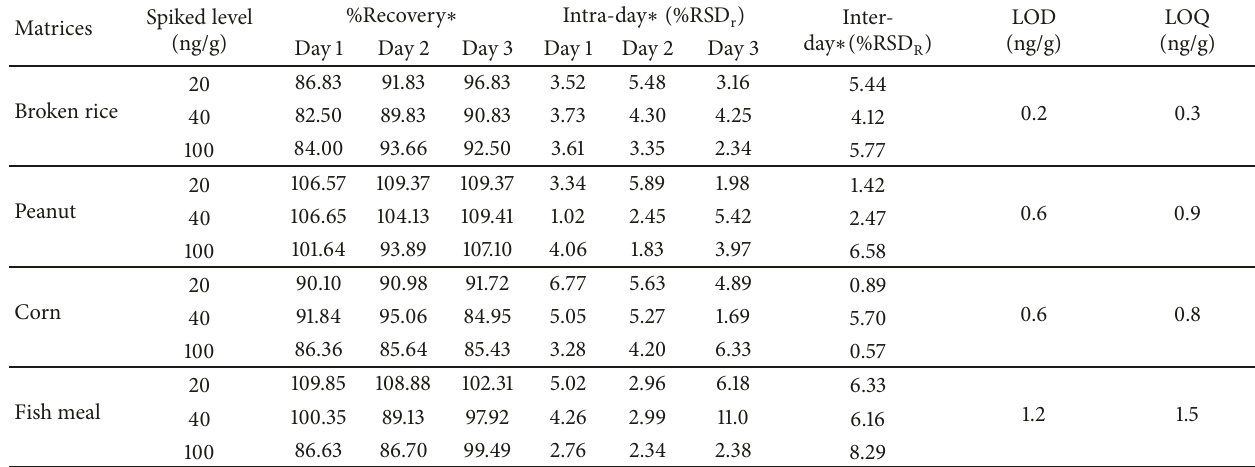
Table 1: The results of validation method with mean value ∗ (accuracy and precision), n=6.